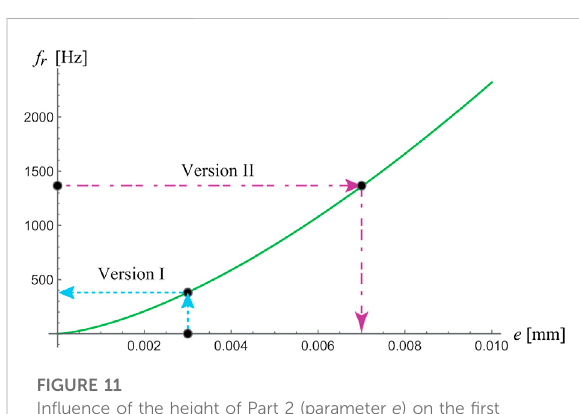
FIGURE 11 In fl uence of the height of Part 2 (parameter e ) on the fi rst bending frequency f r of one internal oscillator and the annotation of the two versions of the redesigned